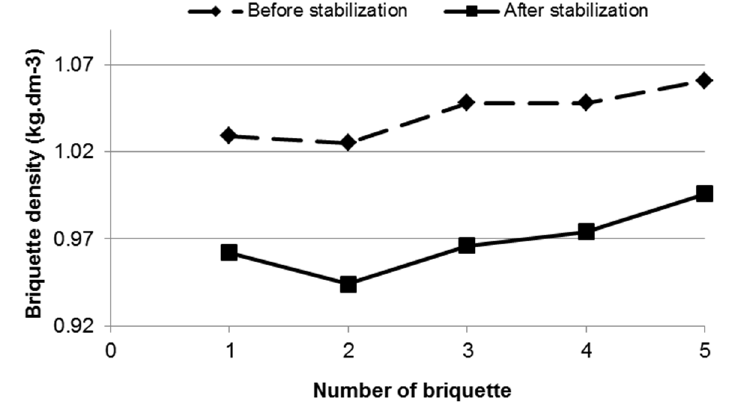
Figure 6. Briquette density values at 95 MPa compression pressure ( w r = 8%; L = 2 mm).